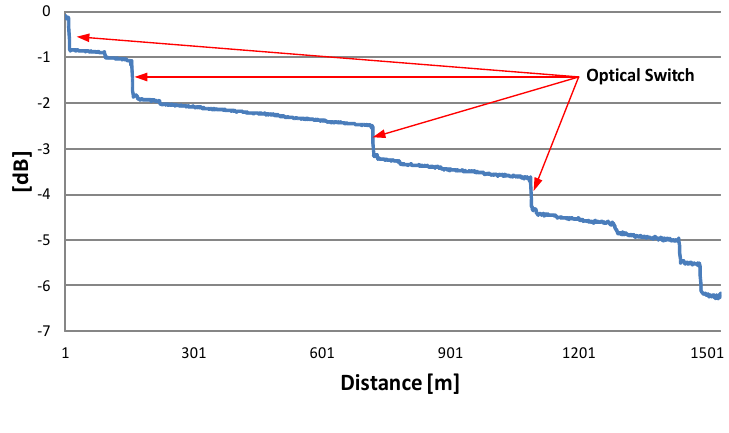
Figure 15. Result of DTS optical loss characteristics test in the